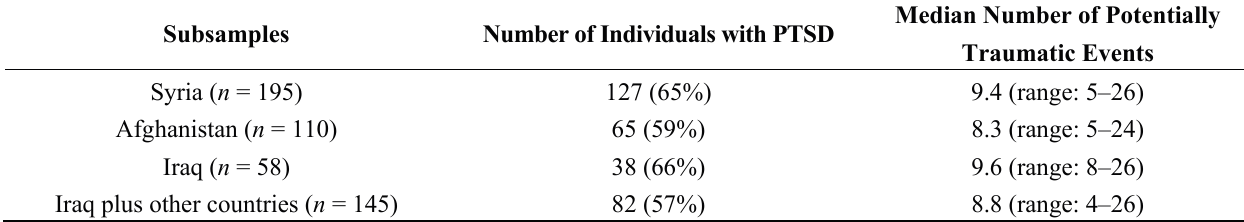
Table 2. Posttraumatic Stress Disorder (PTSD) and potentially traumatic events in three subsamples and in Iraqi asylum